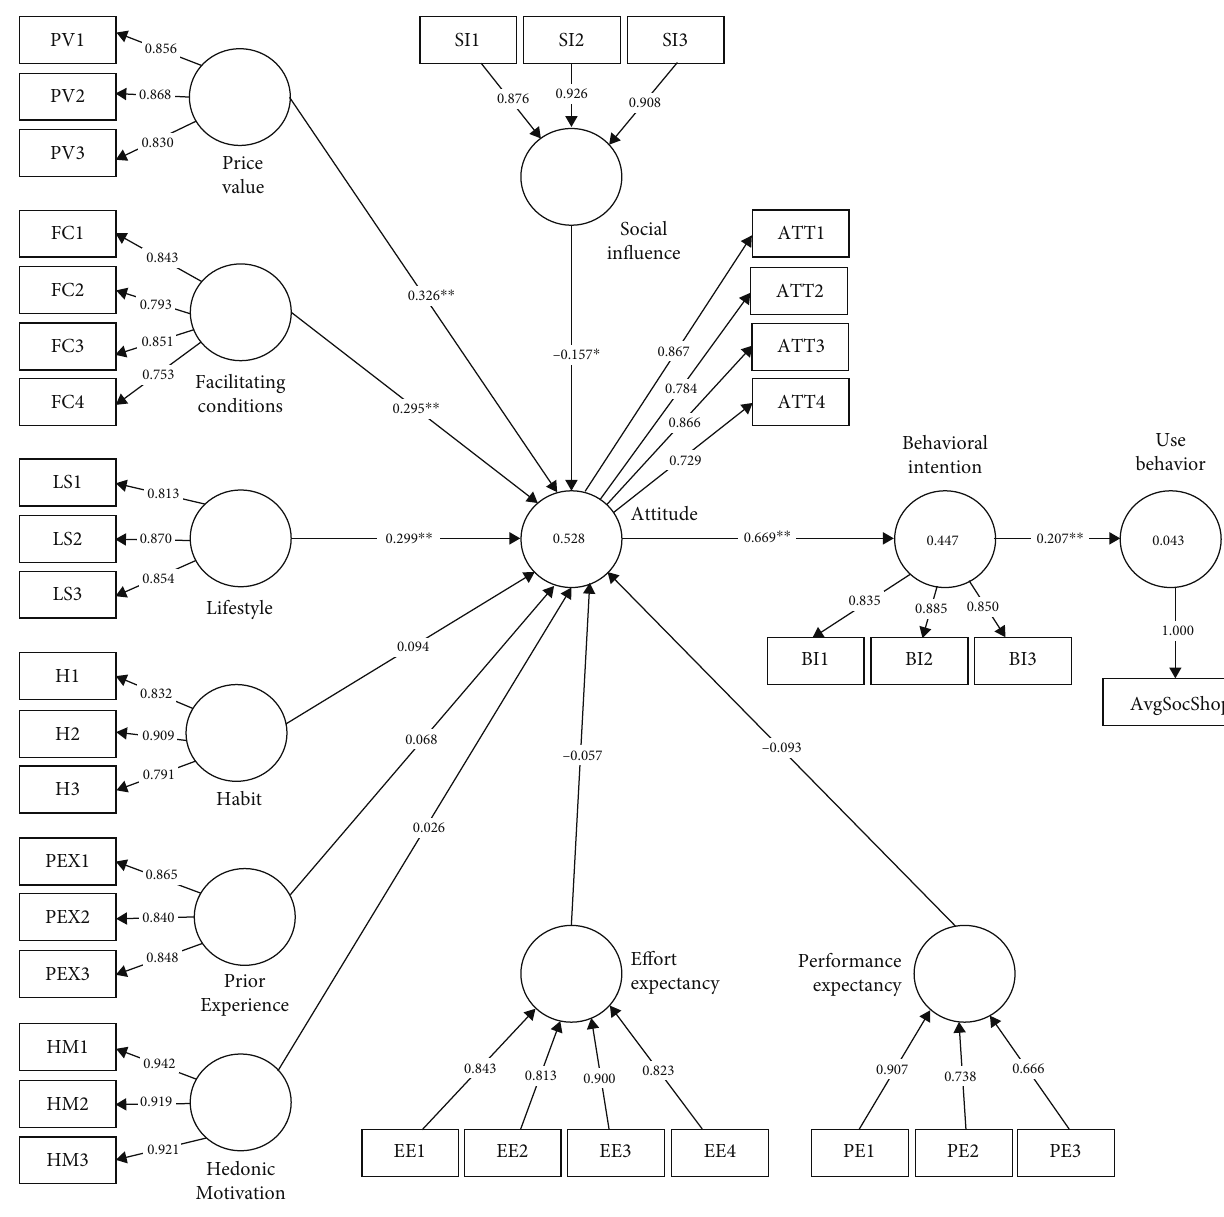
Figure 2: Structural model